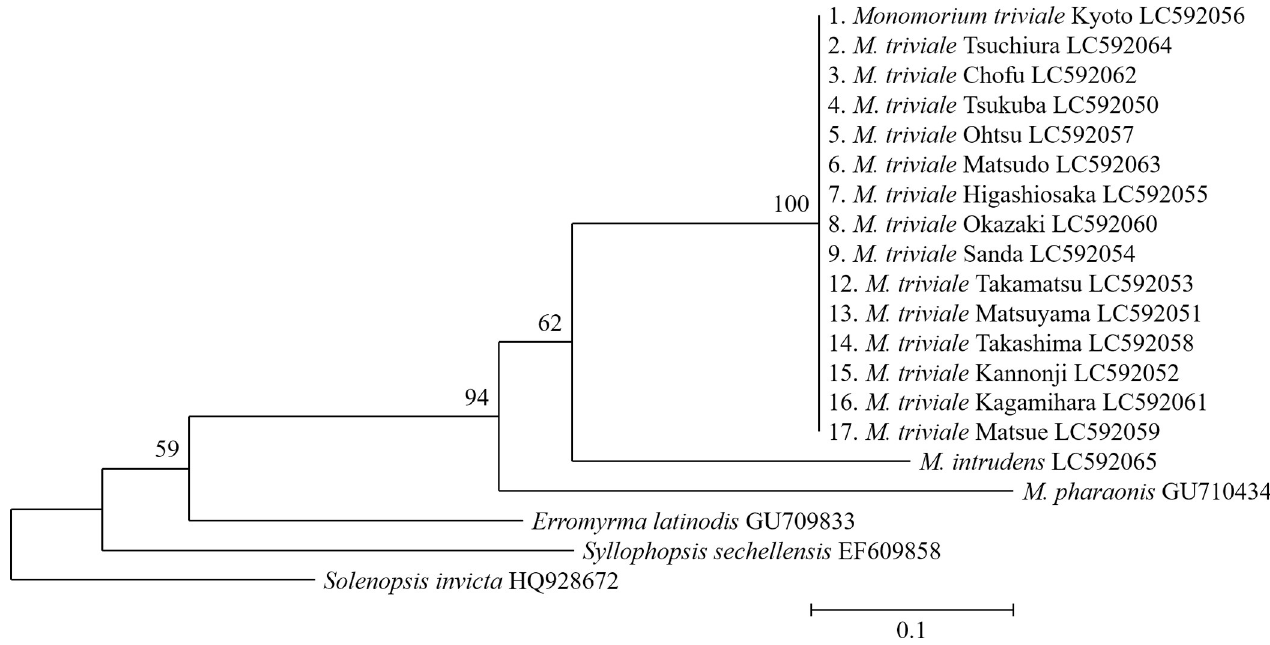
Fig 3. Maximum likelihood tree of 15 populations of M . triviale and related species, based on COI sequences. The number at each branch of the phylogenetic tree represents the bootstrap percentage (1000 replicates). GenBank accession codes follow the taxon names. Scale bar: 0.1 substitutions per site.